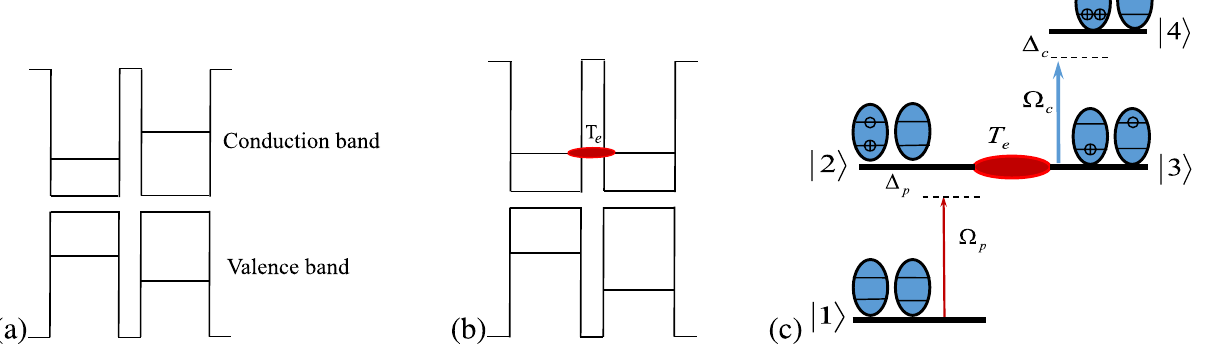
Figure 1. The energy levels of the QDM system before ( a ) and after ( b ) applying the external voltage. ( c ) The energy diagram of the four-level ladder type QDM system and two applied laser fields. The electron and hole are shown by ⊖ and ⊕ ,